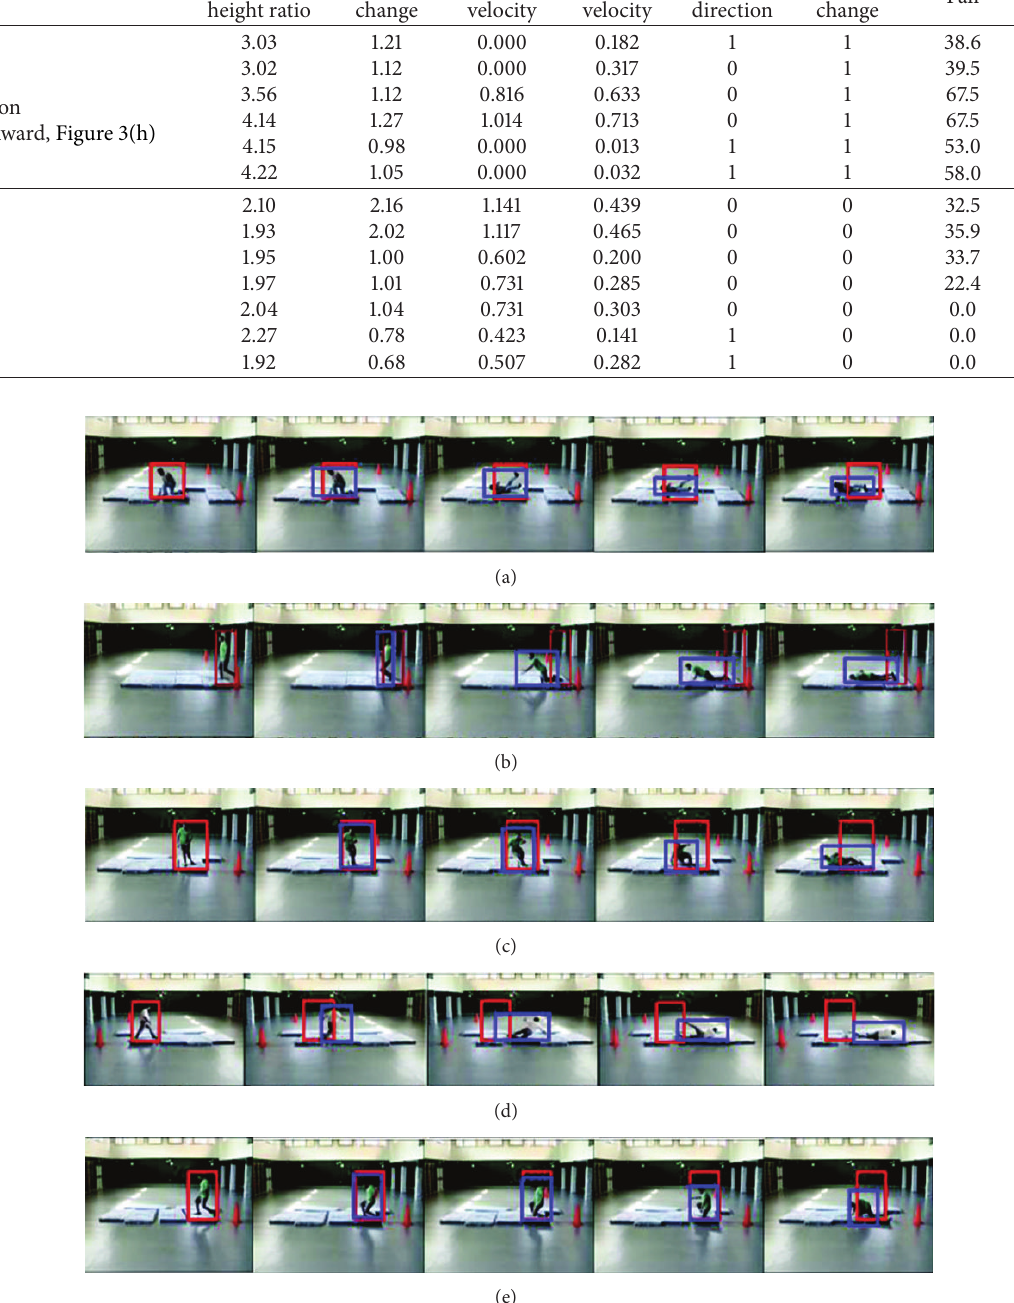
Figure 4: True and false falls recorded with a colour camera. Static fall from a “pruning” position: (a) falling backward. Static falls from a “standing” position: (b) falling forward and (c) falling to the left. Dynamic falls from a “standing” position: (d) falling to the right and (e) falling to the